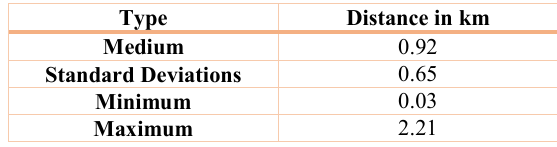
Table 2. Distance between monasteries and villages.